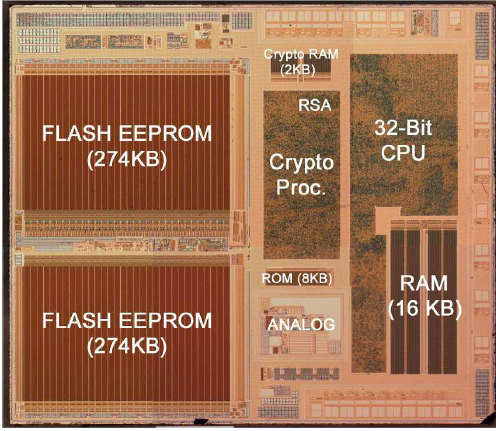
Figure 1: General view of the die after sample opening; mag